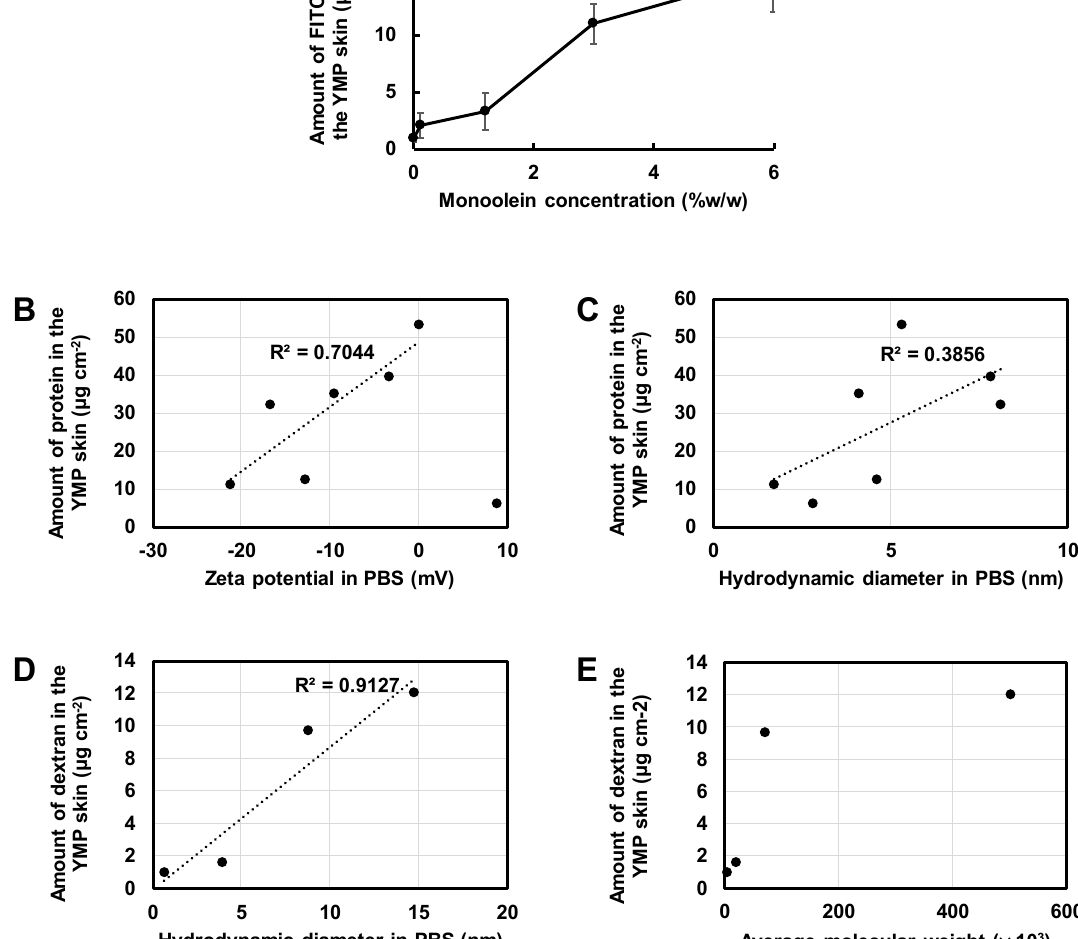
Figure 2. Efficiencies of skin permeation of proteins and dextrans ( n = 3). ( A ) The skin permeability of fluorescein isothiocyanate (FITC)-labeled ovalbumin (OVA) with respect to the concentration of monoolein (MO) dissolved in isopropyl myristate (IPM). ( B , C ) The skin permeabilities of proteins with respect to zeta potential ( B ), and hydrodynamic diameter ( C ) at an MO concentration of 3% w/w . ( D , E ) The skin permeabilities of FITC-labeled dextrans in relation to hydrodynamic diameter ( D ), and average molecular weight ( E ) at an MO concentration of 3% w/w . All values are shown in the supporting information.